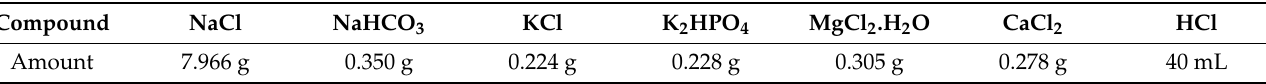
Table 2. Constituents of the SBF